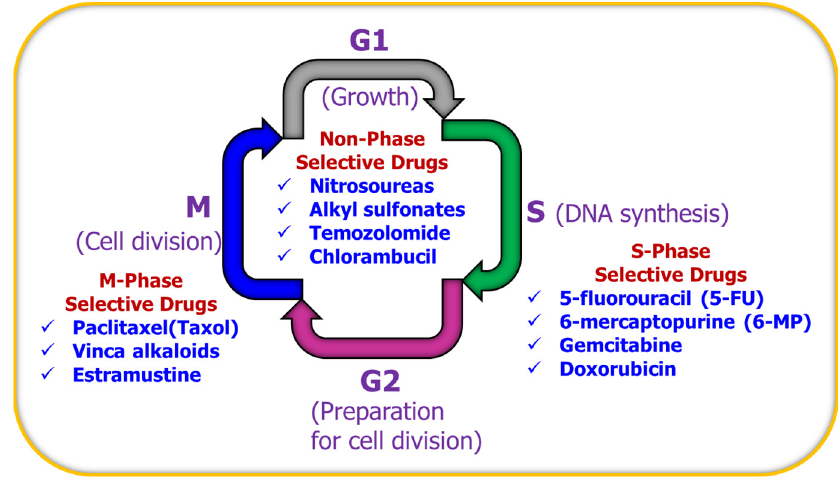
Figure 4. Cell cycle showing the different phases of cell division.